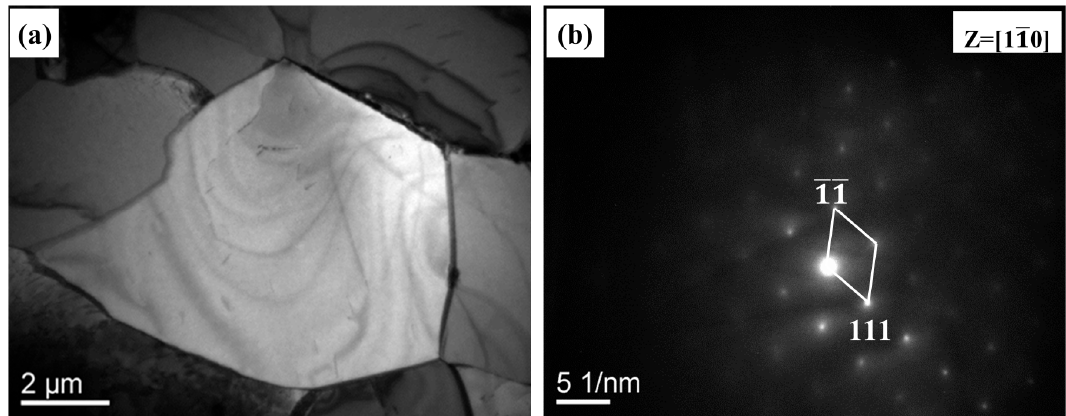
Figure 8. TEM images of specimens deformed at 1250 °C and 10 s − 1 : ( a ) dynamic recrystallization (DRX) grain of austenite; ( b ) SAED result.